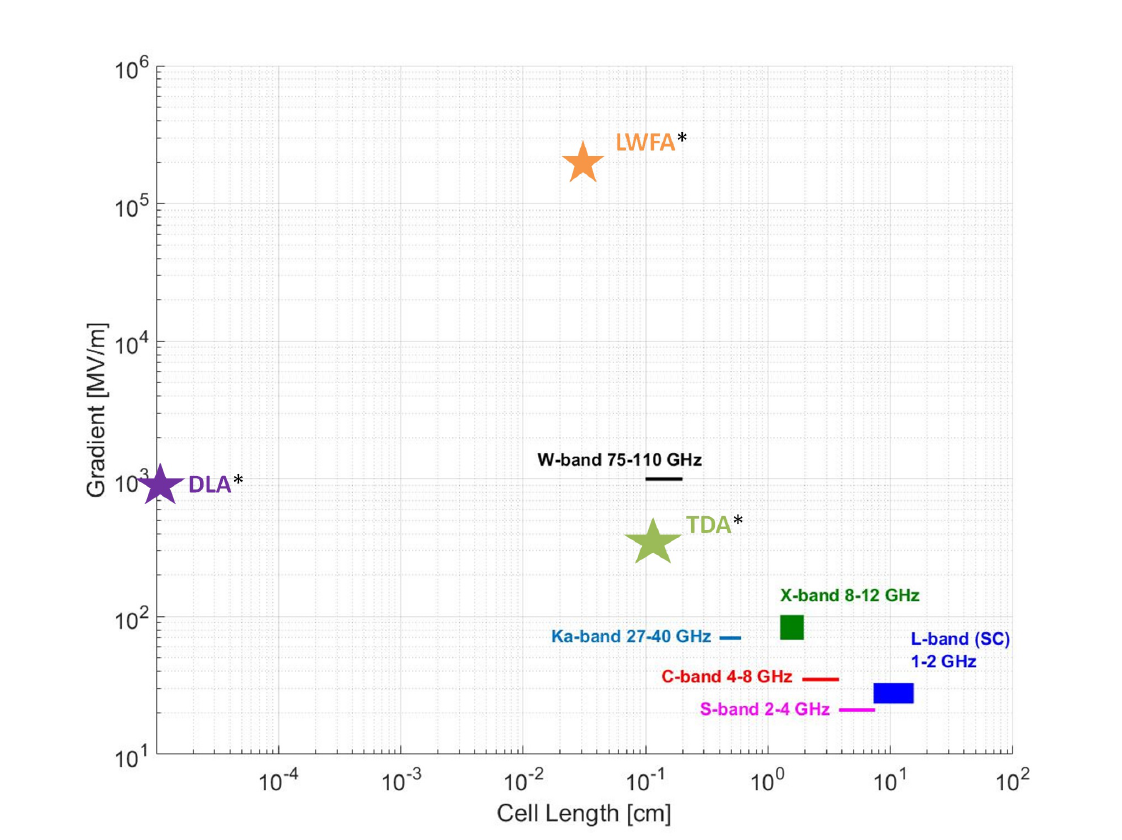
Figure 1. Scaling of the maximum achievable gradient versus the cell length in conventional accelerators. The gradients provided by novel acceleration techniques are superimposed to the plot and indicated with a star-symbol. For those items, also marked with an asterisk, the wavelength of the accelerating field has been plotted instead of the cell length. In the figure are used the following abbreviations: LWFA (Laser Wake-Field Accelerator), DLA (Dielectric Laser Accelerator) and TDA (THz Driven Accelerator).